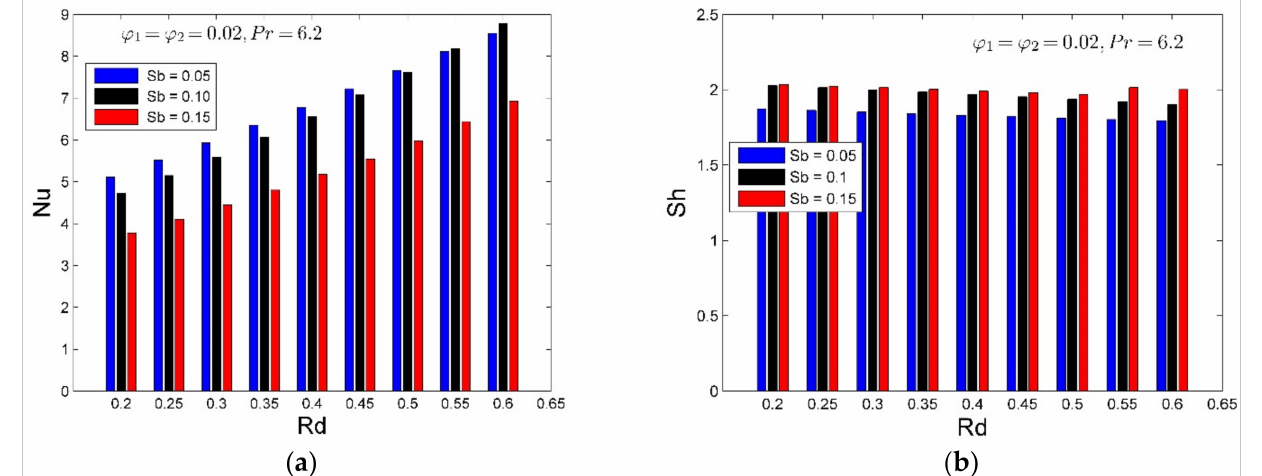
Figure 8. Influences of Sb on Nu and Sh .